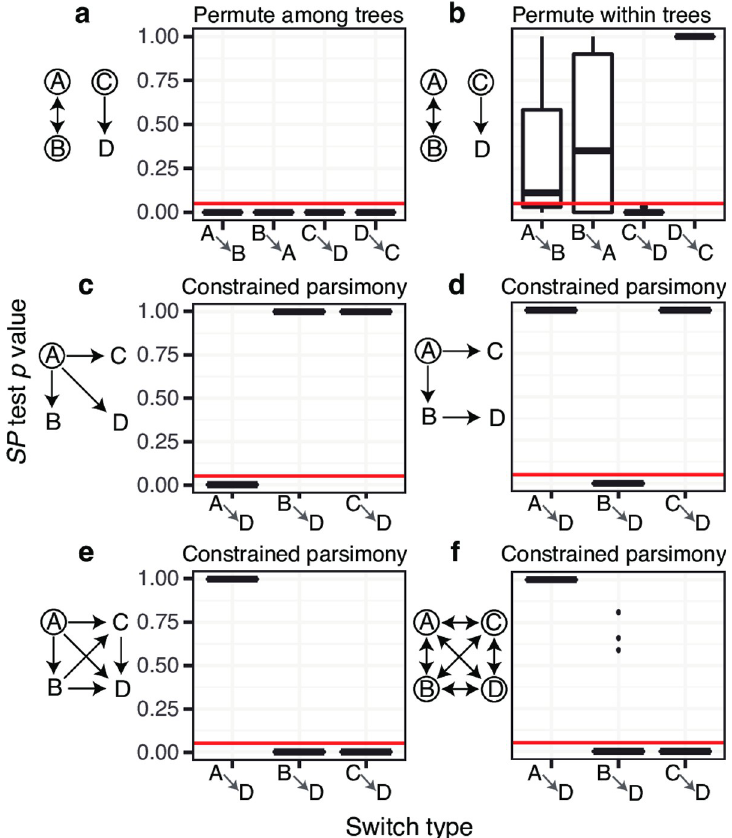
Fig 3. Distribution of SP test p values from four state simulation analyses under multiple modes of evolution diagrammed to the left of each plot. Twenty repetitions were performed in each scenario. In simulations, possible starting states are circled and possible state changes are shown with arrows. All allowed state changes occurred at the same relative rate and the total rate of state change ( r ) was 10 changes/mutation/site (see Fig 2 ). (a) Permuting trait values among trees reveals low p values for all state changes between A and B , and between C and D . (b) Permuting within each tree reveals low p values from C to D , but not between A and B . Both a and b imposed no constraints on the types of state changes allowed in the maximum parsimony algorithm. (c) Direct switching simulations result in low p values from A to D , but not from other states to D . (d) Sequential switching simulations result in low p values from B to D but not from other states to D . (e) Irreversible switching simulations result in low p values from B and C to D , but not from A . (f) Unconstrained switching simulations also result in low p values from B and C to D , but not from A . The strange results of e and f are likely artefacts of the constrained parsimony algorithm, which forbids reverse alphabetical state changes (e.g. D to C ), used to count state changes in simulations c-d